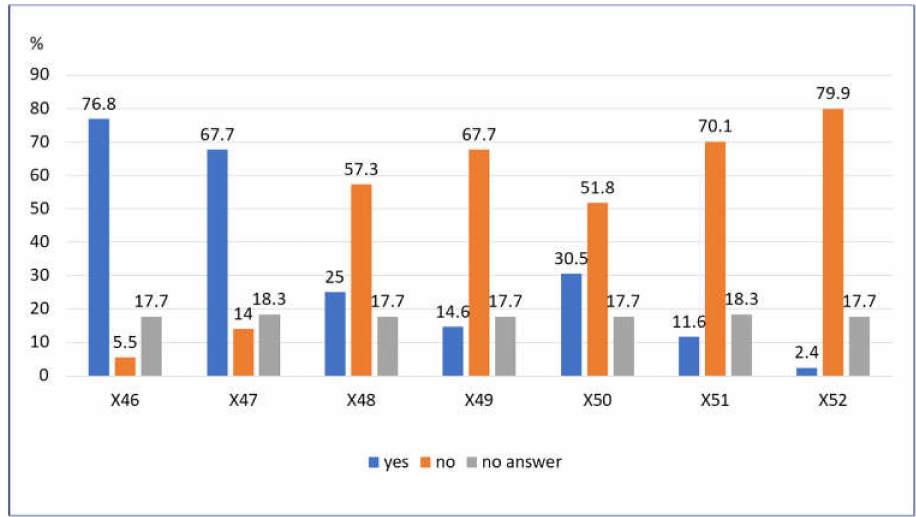
Figure 6. Sources of information about electric cars by the respondents (N =